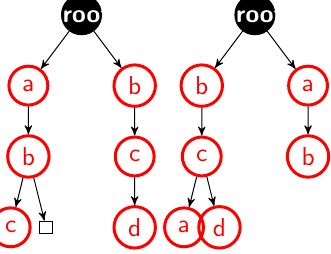
Figure 4. Two trees representing multiset {{ a , b , c } , { b , c , d } , { a , b }}